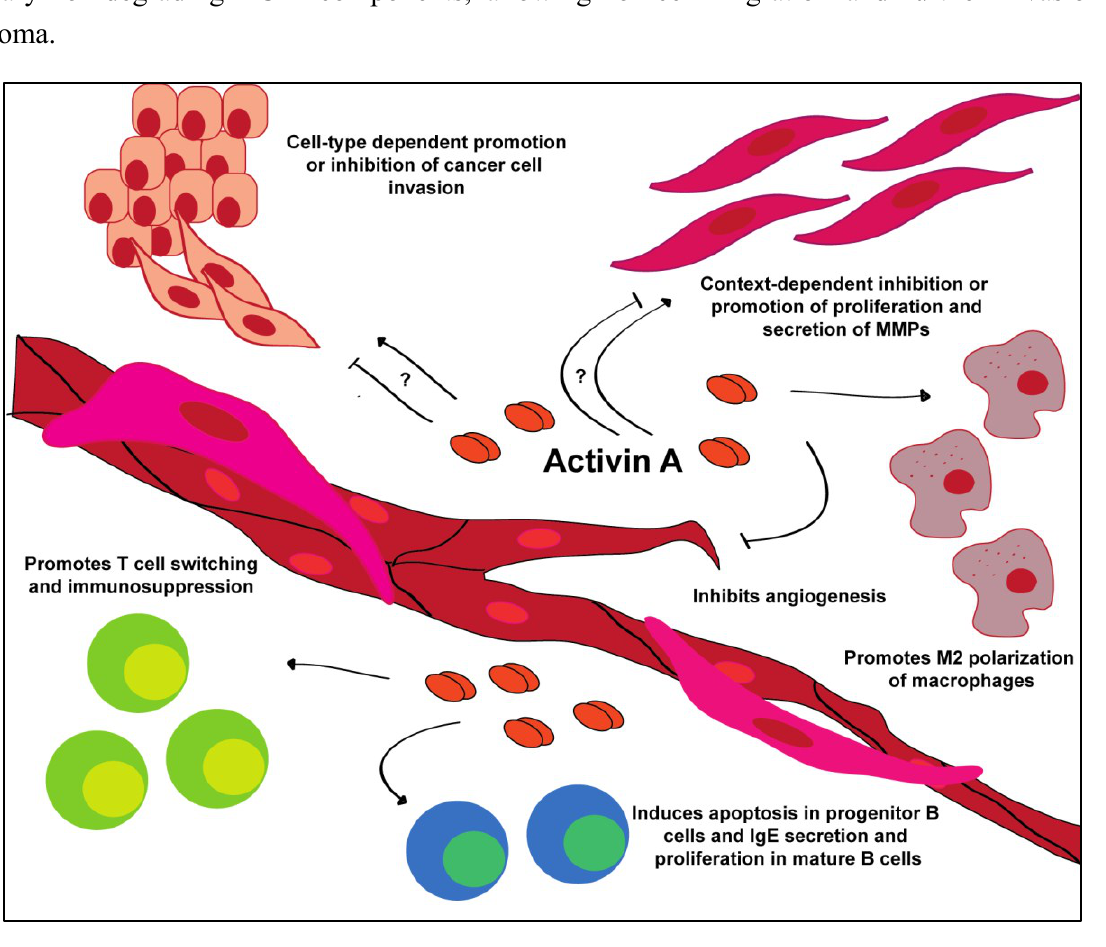
Figure 3. Tumor microenvironmental interactions of activin A. Activin A promotes a variety of behaviors in a cell-type and context-dependent